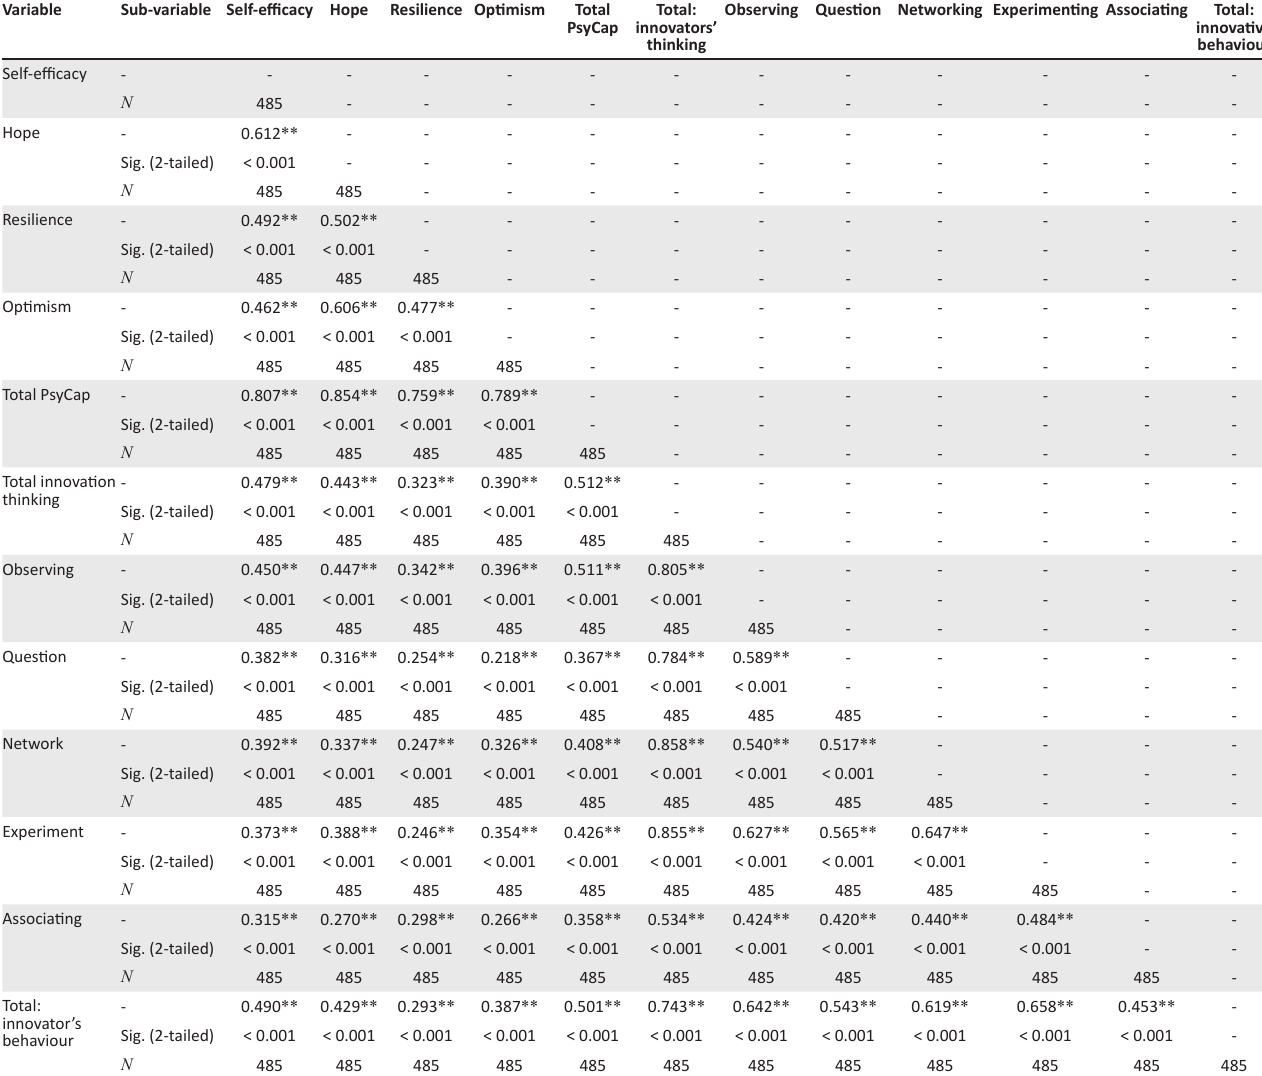
TABLE 4: Pearson’s correlation matrix. Variable